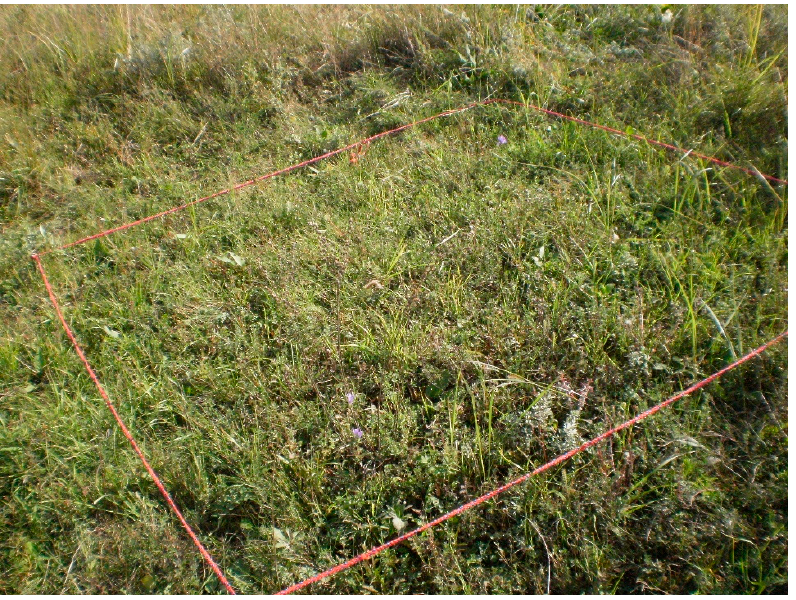
Figure 1. Mown quadrat No. 7. Biomass investigations were applied in June and in September annually. Parallel with coenological recordings, a 2 × 2 m grassland plot was trimmed by a trimmer leaving 4 cm high stubble to model the grazing-effect of